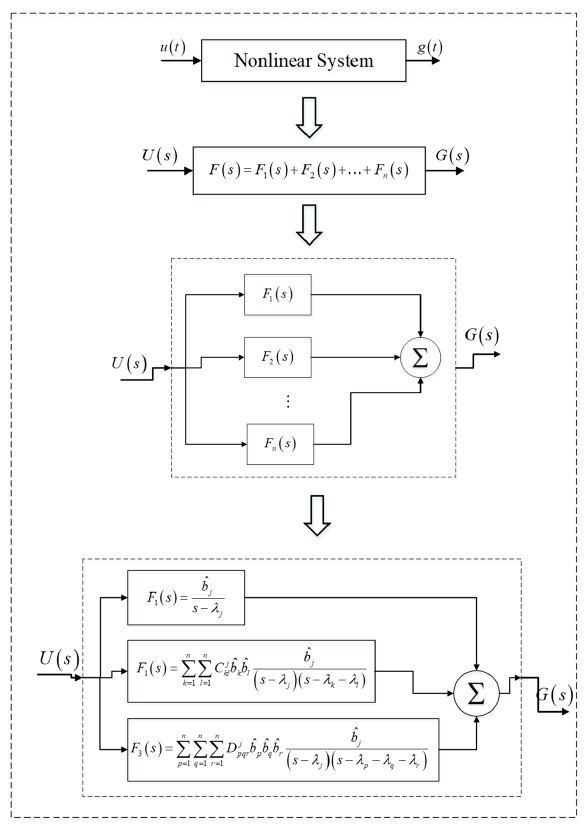
Figure 3. Schematic representation of transfer function for the nonlinear system.